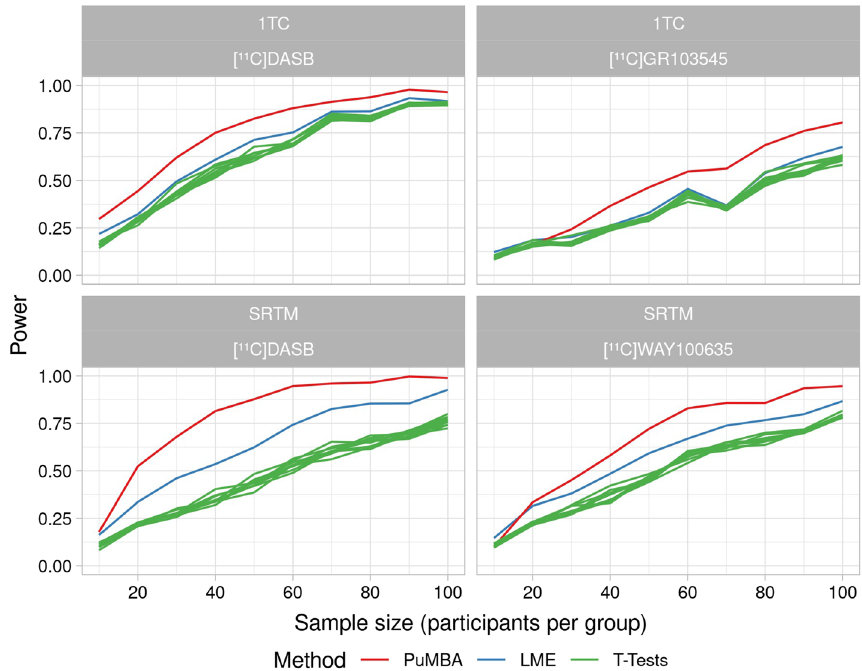
Fig. 6 Power as a function of sample size for a 0.1 difference between patients and controls. The models are the one‑tissue compartment model (1TC) and the simplified reference tissue model